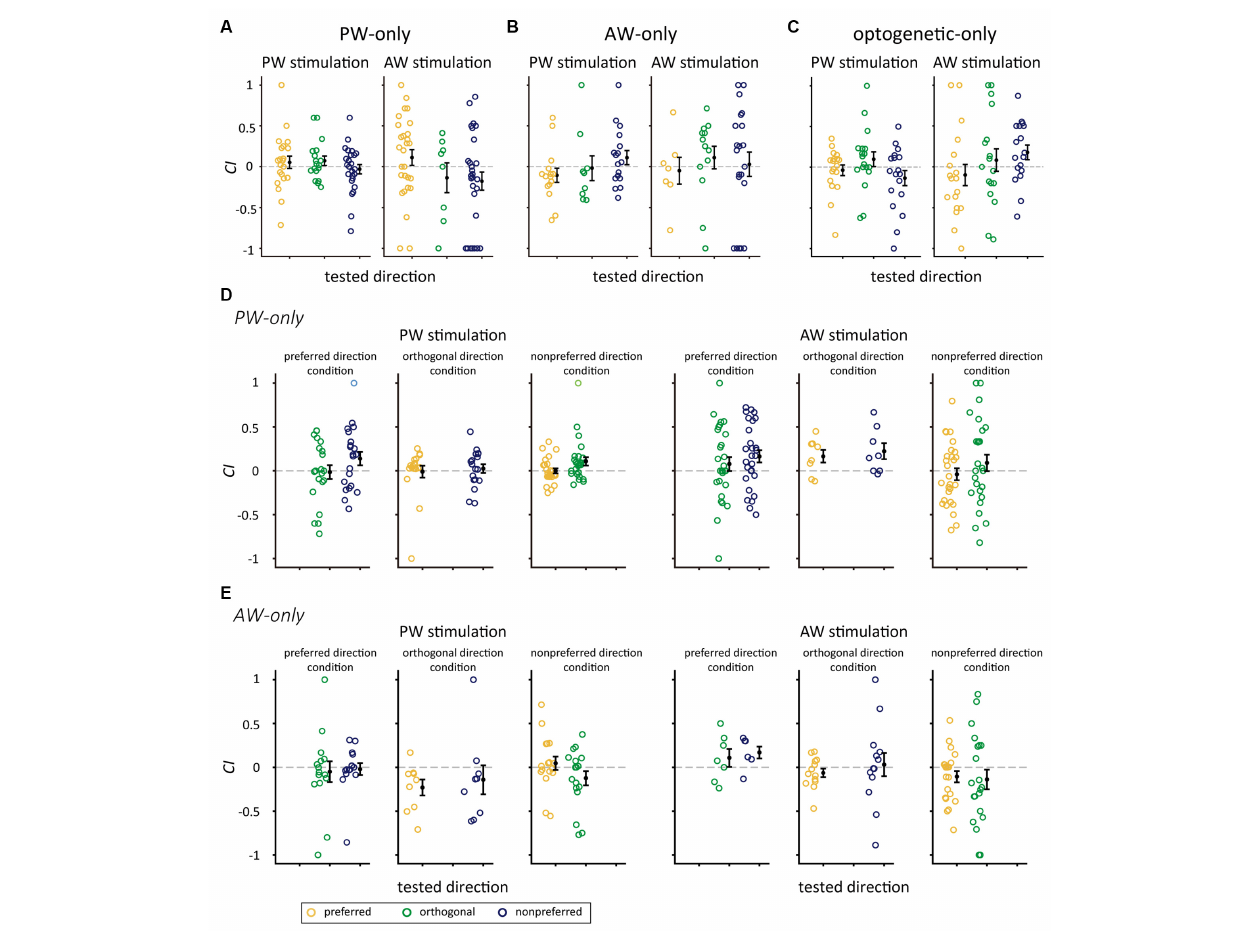
FIGURE 6 | CI s for the mechanical-only and optogenetic-only control groups. (A) CI s for the stimulated direction in the PW-only group. (B) CI s for the stimulated direction in the AW-only group. (C) In the optogenetic-only group, the CI s for PW (left panel) and AW (right panel) stimulation in the preferred, orthogonal, or nonpreferred directions were not altered by repetitive optogenetic stimulation ( p > 0.05/3 in all conditions, Wilcoxon signed-rank test, Bonferroni correction). (D) The PW-only group. CI s for whisker stimulation in directions showed in Figure 5A except the repetitively stimulated direction (blank in each panel). Left panel: CI s for PW stimulation. Right panel: CI s for AW stimulation ( p > 0.05/2 in all conditions). (E) The AW-only group. CI s for whisker stimulation in directions showed in Figure 5A except the repetitively stimulated direction (blank in each panel). Left panel: CI s for PW stimulation. Right panel: CI s for AW stimulation ( p > 0.05/2 in all conditions). The color convention is the same as in Figure 5 .